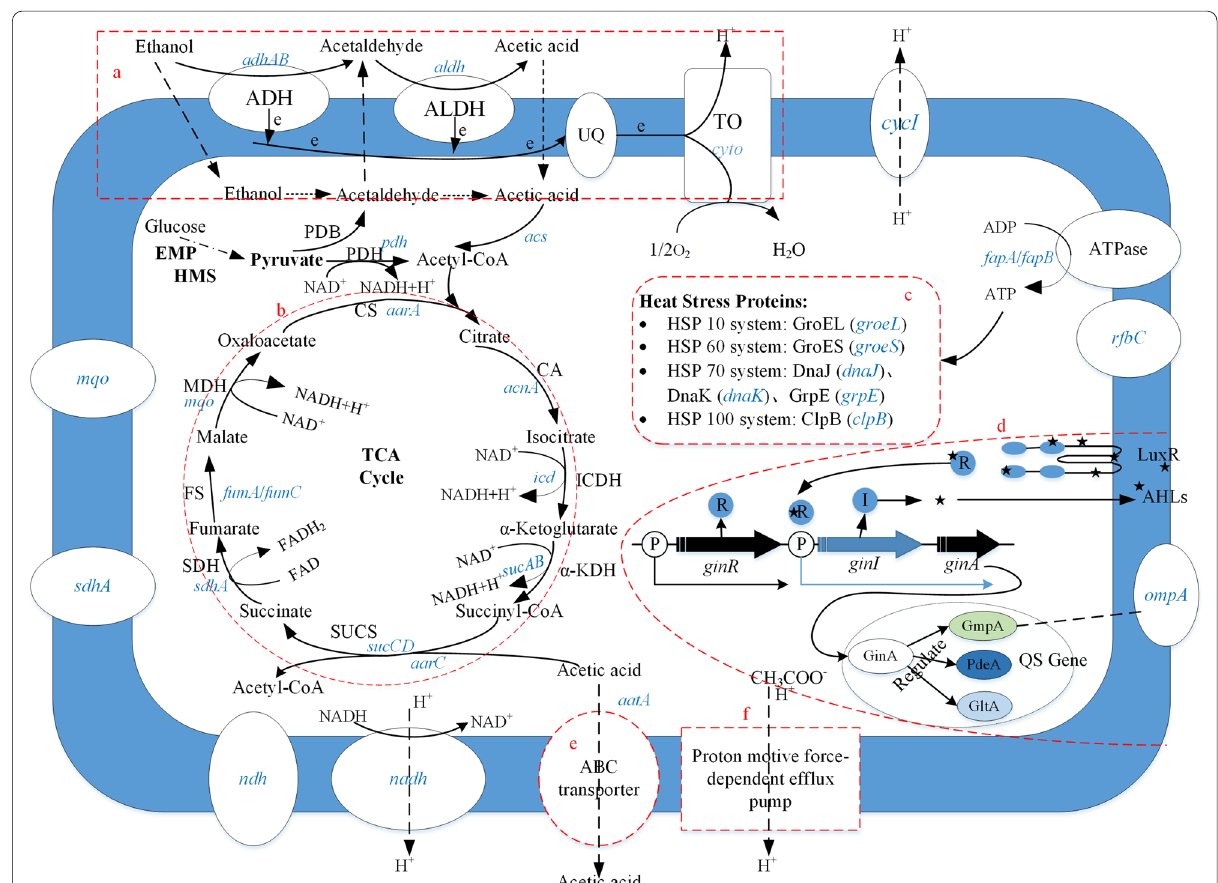
Fig. 1 The metabolic pathways and mechanism of acetic acid resistance recorded in AAB. a The ethanol oxidation respiratory chain pathway; b The tricarboxylic acid (TCA) cycle pathway; c The heat stress proteins (HSPs); d A putative schematic representation of quorum sensing (QS) regulating modules in the cell membrane of Gluconacetobacter intermedius ; e The ATP-binding cassette (ABC) transporter; f The proton motive force-driven efflux pumps. ADH, Alcohol dehydrogenase; ALDH, Acetaldehyde dehydrogenase; UQ, Ubiquinone; TO, Terminal oxidase; PDB, Pyruvate decarboxylase; PDH, Pyruvate dehydrogenase; CS, Citrate synthase; CA, Cis aconitase; ICDH, Isocitrate dehydrogenase; KDH, Ketoglutarate dehydrogenase; SUCS, Succinyl CoA synthase; SDH, Succinate dehydrogenase; FS, Fumarate synthase; MDH, Malate dehydrogenase; EMP, Glycolytic pathway; HMS, Hexose monophosphate